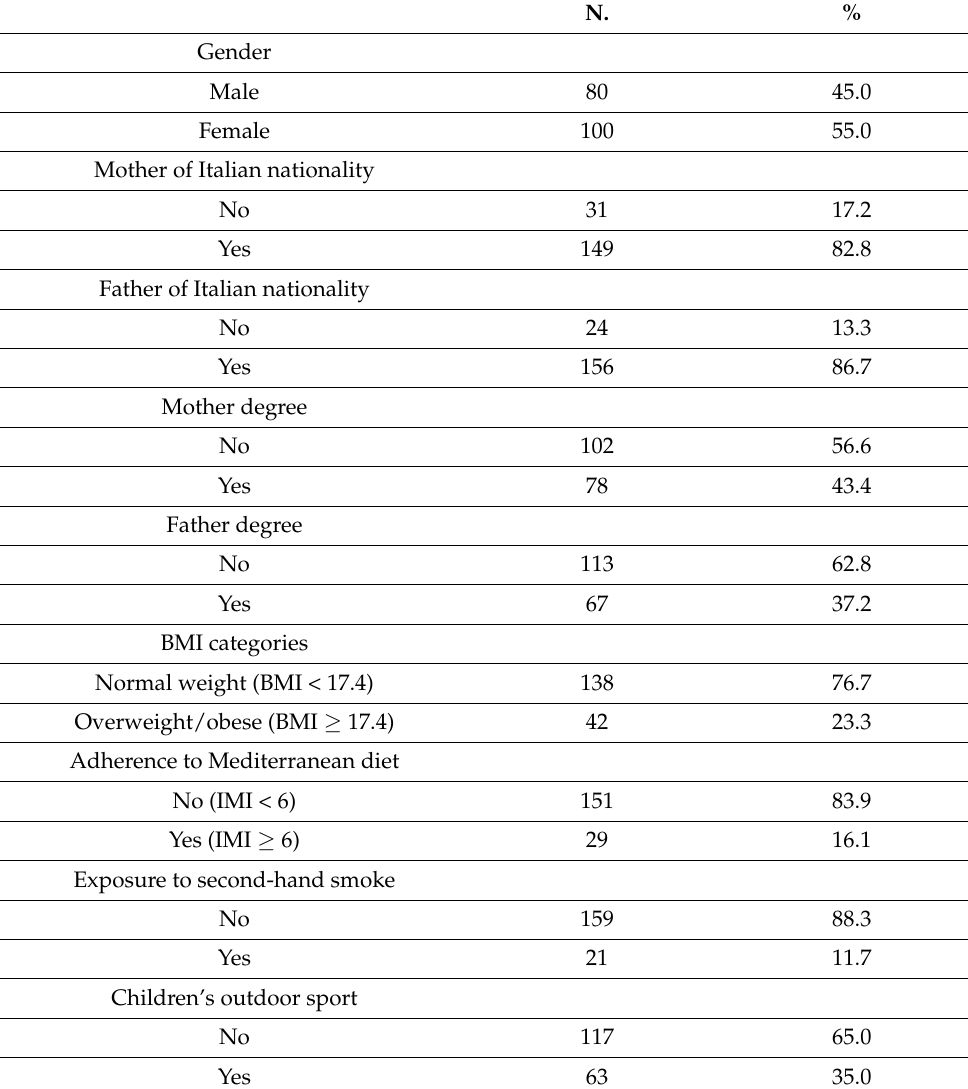
Table 1. Characteristics of children enrolled in the study and twice sampled: socio-demographic, anthropometric characteristics and lifestyle.